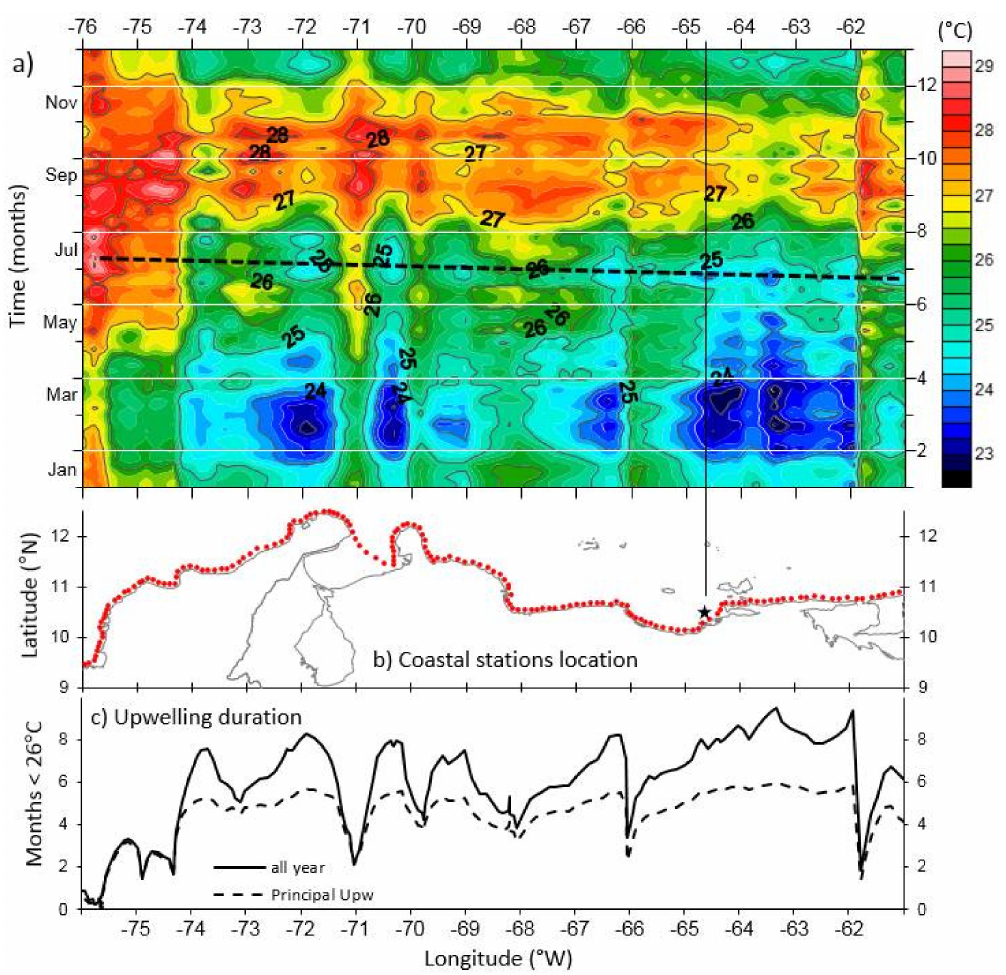
Figure 2. Seasonal coastal sea surface temperature (SST) in the southern Caribbean upwelling system. ( a ) Seasonal SST cycle along the coast, calculated with long-term weekly SST means (1994–2009) derived from AVHRR satellite imagery (isotherm contours are every 1 ◦ C). SST time series were extracted at 172 coastal stations approximately 13 km offshore, at locations shown as red dots in the map ( b ), along the coastlines (gray), from left to right, of Colombia, Venezuela, and Trinidad. ( c ) Mean duration of coastal waters under 26 ◦ C during the principal upwelling (December to May) and for the whole year. The principal upwelling season was synchronous along the southern Caribbean and peaked in February–March; the mid-year upwelling peaked around June–July with a lag of ~2 weeks toward the west between 61–75 ◦ W, as shown by the black broken line in panel ( a ). Coastal SST at the longitude of the CARIACO Ocean Time-Series station is highlighted with a vertical black solid line in panel ( a ), and the station position is shown with a black star in panel ( b